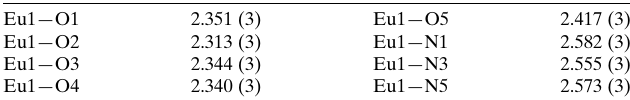
Table 1 Selected bond lengths (A˚